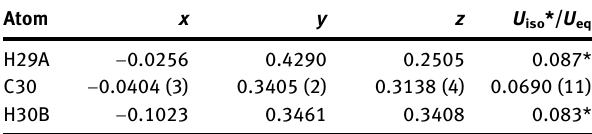
Table  : Fractional atomic coordinates and isotropic or equivalent isotropic displacement parameters (Å 